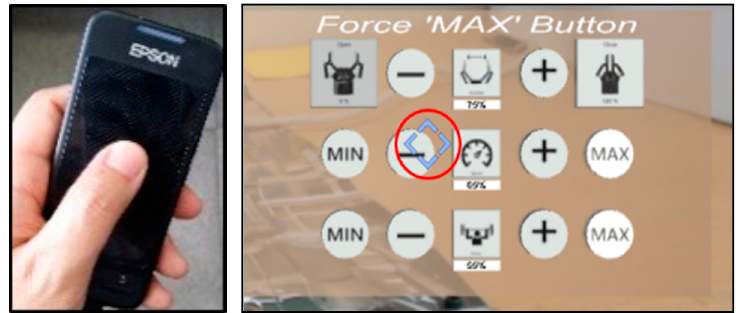
Figure 7. Multi-touch interaction using a touchpad in AR smart glasses.